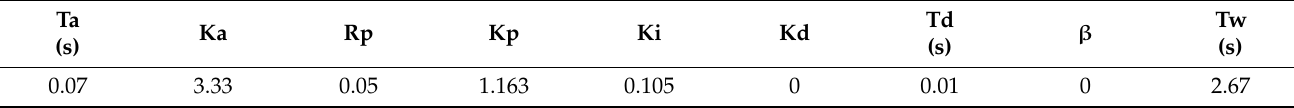
Table A7. Hydroelectric power plant parameters (speed governor).